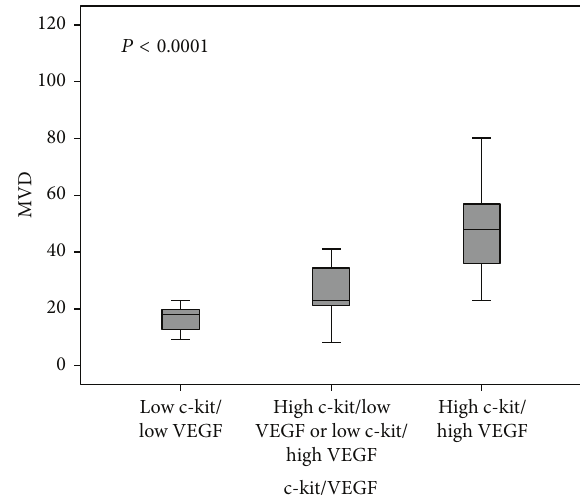
Figure 4: Association of CD3+ T-lymphocytes and c-kit in malig- nant canine mammary tumors.